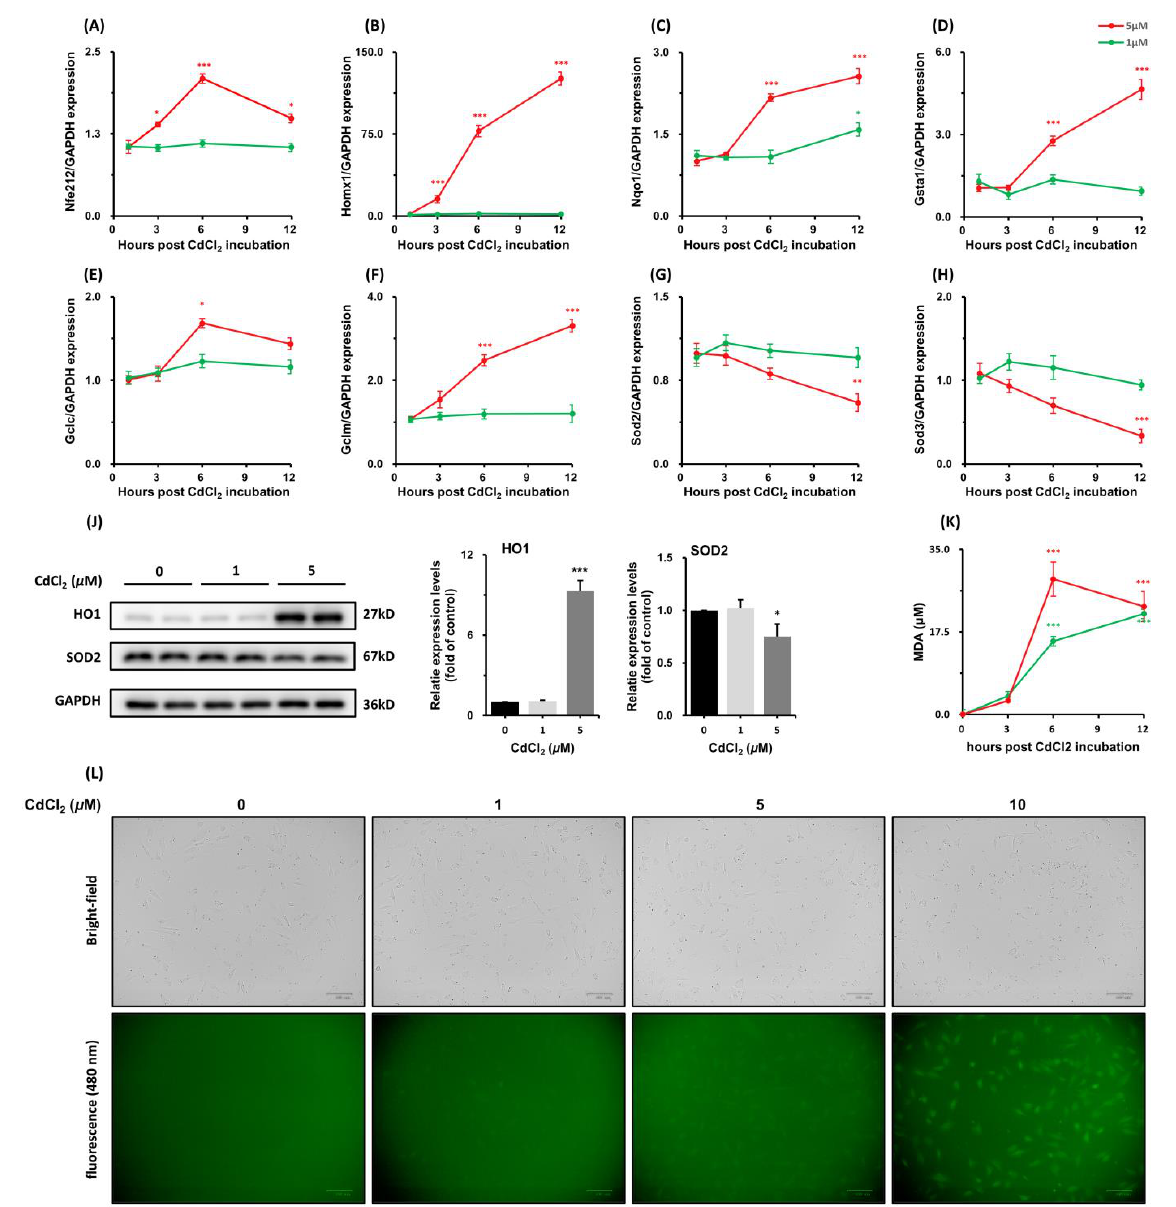
Figure 4. CdCl 2 induced oxidative stress in TM4. The mRNA levels of Nrf2-related genes were measured using qPCR after treatment with CdCl 2 for 1, 3, 6, and 12 h ( A – H ). The protein levels of HO1 and SOD2 at 12 h were measured by immunoblotting ( I ). ROS level induced by treatment with CdCl 2 for 2 h was measured by a fluorescence probe (DCFH-DA). Representative images illustrate the presence of fluorescent DCF ( K ), an oxidation product of DCFH oxidized by ROS. The MDA levels were measured after treatment with CdCl 2 for 1, 3, 6, and 12 h ( J ). * p < 0.05 compared to the control group, ** p < 0.01 compared to the control group, and *** p < 0.001 compared to the control group.